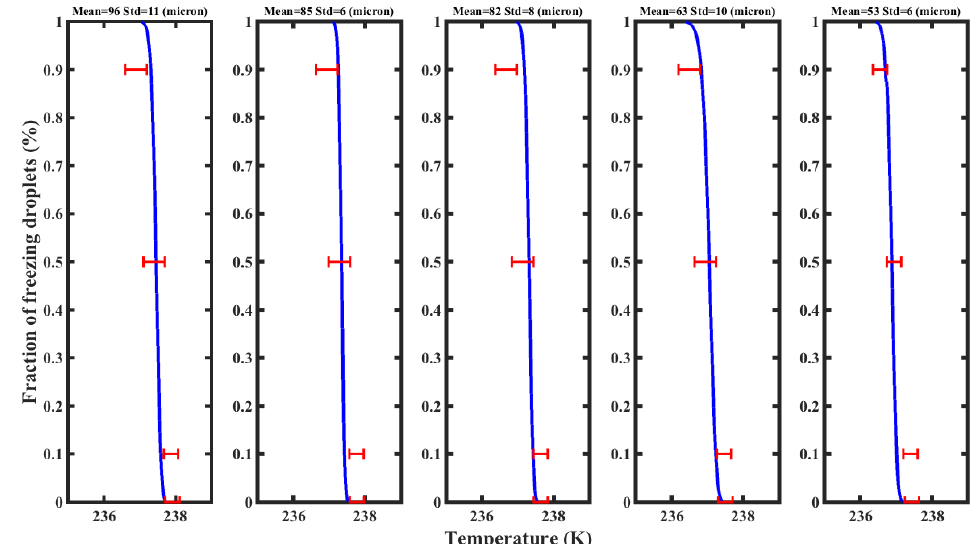
Figure 5. Comparison between the experimental results of the fraction experiment from Riechers et al. (2013) and the theoretical estimates derived here. Red: experimental results with uncertainties from Riechers et al. (2013). Blue: theoretical estimates ( σ i / w , e from the TIP4P